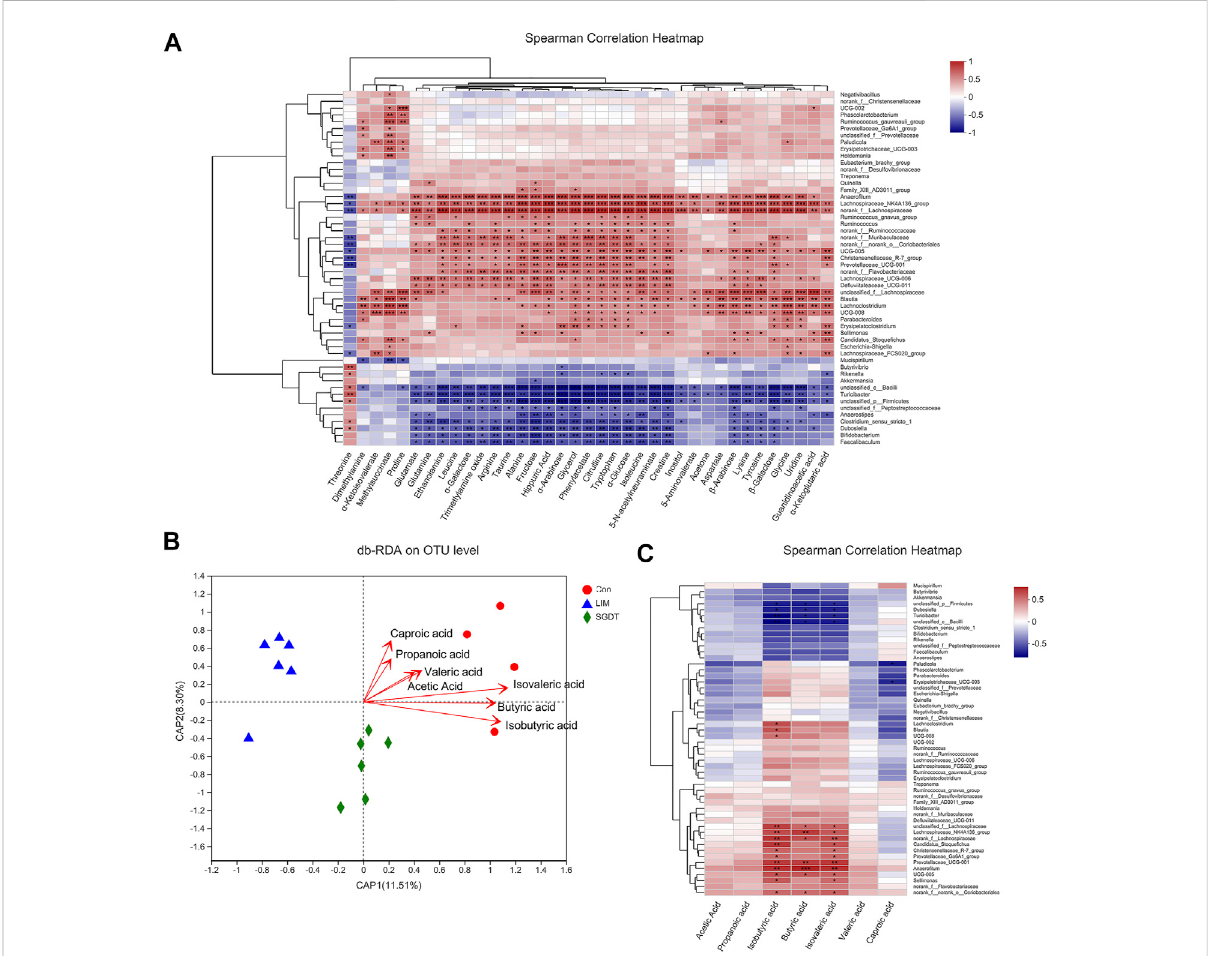
FIGURE 6 Correlation analysis of gut microbiota with SCFAs and fecal metabolites. (A) Spearman ’ s correlation analysis of 52 marker bacterial taxa and 37 fecal metabolites. (B) db-RDA analysis of gut microbiota and SCFAs. (C) Spearman ’ s correlation analysis of 52 marker bacterial taxa and